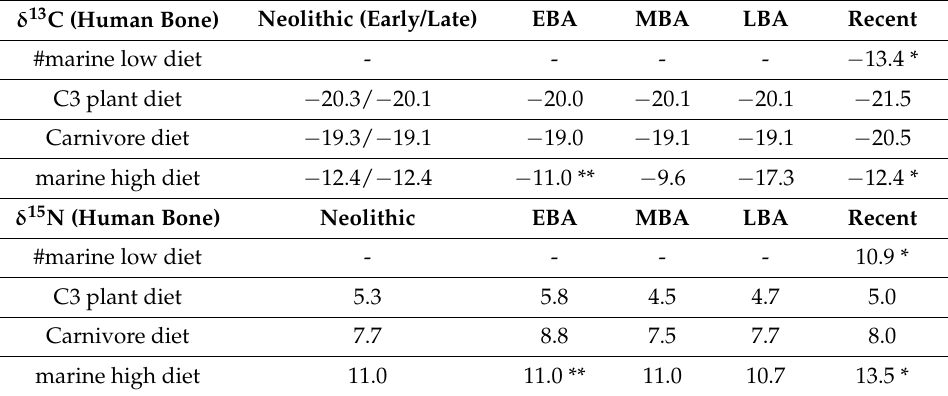
Table 5. Theoretical Isotopic values of human bones under extreme